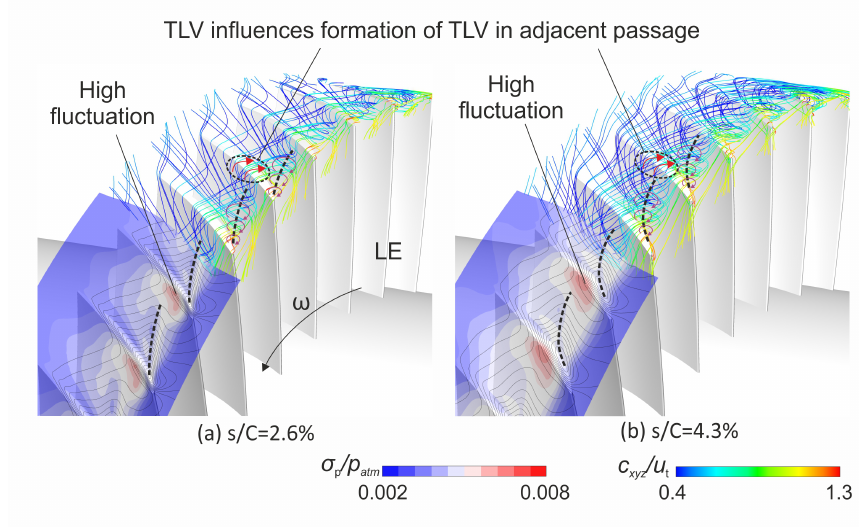
Figure 9. Normalized standard deviation of wall pressure and normalized velocity distribution of ensemble-averaged tip leakage flow in CFD results ( s / C = 2.6% at Φ = 0.50; s / C = 4.3% at Φ = 0.51, presented in the rotating